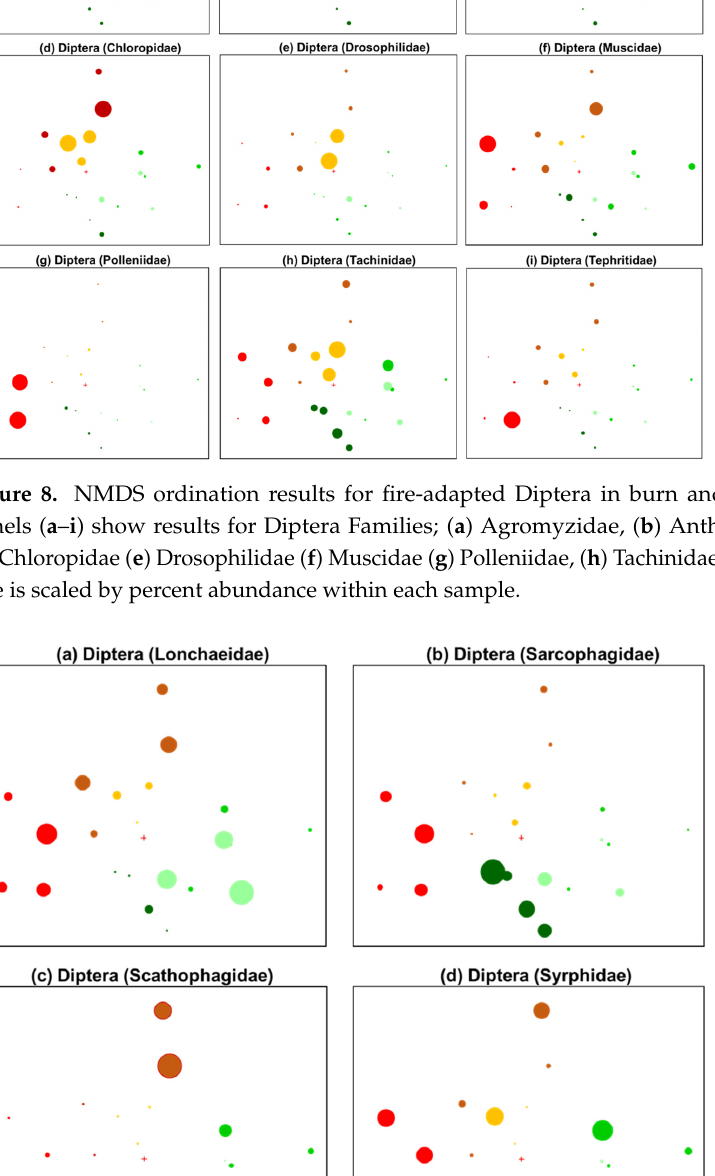
Figure 10. NMDS ordination results for negatively impacted Diptera in burn study sites. Panels ( a – d ) show results for Diptera Families; ( a ) Bombyliidae, ( b ) Dolichopodidae, ( c ) Phoridae, ( d ) Pipun- culidae. Symbol size is scaled by percent abundance within each sample. 4. Discussion